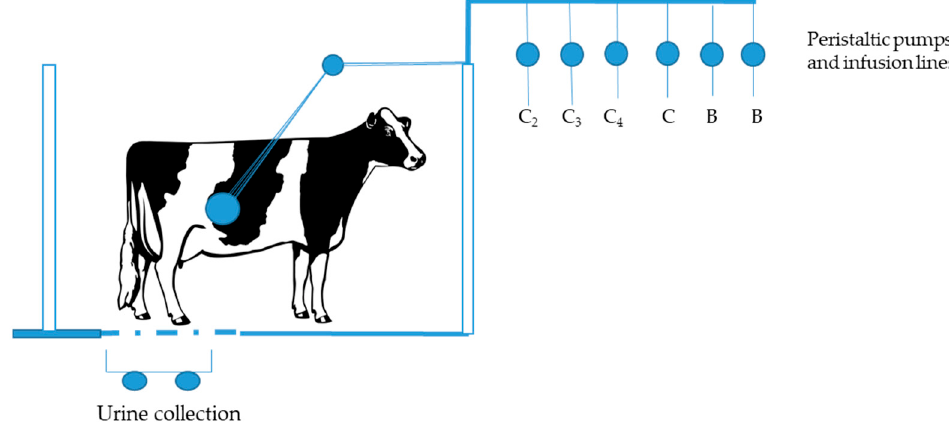
Figure 1. Schematic representation of the total intragastric infusion technique. C 2 —acetic acid; C 3 —propionic acid; C 4 —butyric acid; C—casein; B—buffer.